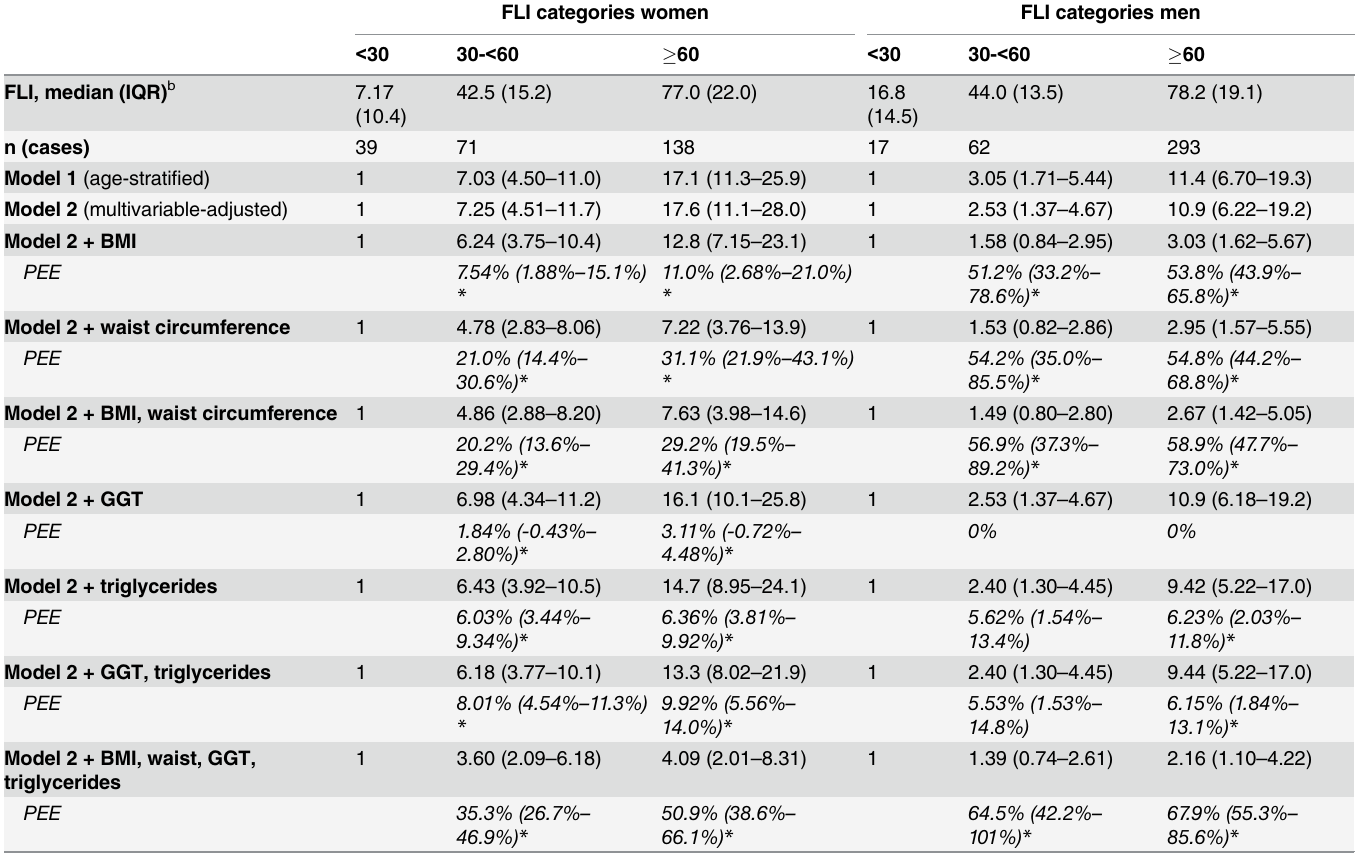
Table 2. HR (95% CI) for type 2 diabetes by categories of the fatty liver index in EPIC-Potsdam a